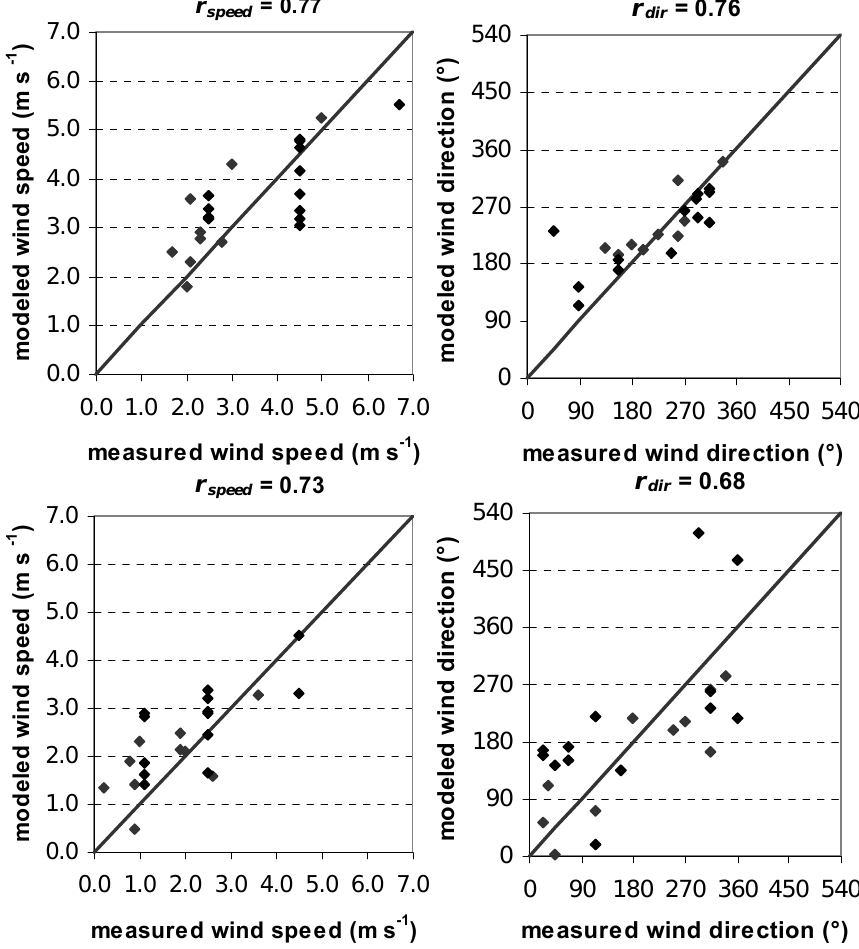
Fig. 3. The modeled versus measured hourly averaged surface wind speed (left) and wind direction (right) for 19 June 2000 at 14:00h (top) and at 21:00h (bottom). Black diamonds mark the comparison between the model and the data obtained from both automatic meteorological and climatological stations (signed and unsigned dots in Fig. 1). The corresponding correlation coefficient is also given at each panel. In Figure 3: The modeled versus measured hourly averaged surface wind speed (left) and wind Figure 3: The modeled versus measured hourly averaged surface wind speed (left) and wind order to show exact discrepancies between the measured and modeled directions, wind directions spanning a range of 0–90 ◦ are sometimes enlarged by 360 ◦ direction (right) for 19 June 2000 at 1400 h (top) and at 2100 h (bottom). Black diamonds direction (right) for 19 June 2000 at 1400 h (top) and at 2100 h (bottom). Black diamonds Figure 3: The modeled versus measured hourly averaged surface wind speed (left) and wind Figure 3: The modeled versus measured hourly averaged surface wind speed (left) and wind mark the comparison between the model and the data obtained from both automatic direction (right) for 19 June 2000 at 1400 h (top) and at 2100 h (bottom). Black diamonds meteorological and climatological stations (signed and unsigned dots in Fig. 1). The direction (right) for 19 June 2000 at 1400 h (top) and at 2100 h (bottom). Black diamonds mark the comparison between the model and the data obtained from both automatic corresponding correlation coefficient is also given at each panel. In order to show exact mark the comparison between the model and the data obtained from both automatic meteorological and climatological stations (signed and unsigned dots in Fig. 1). The discrepancies between the measured and modeled directions, wind directions spanning a meteorological and climatological stations (signed and unsigned dots in Fig. 1). The corresponding correlation coefficient is also given at each panel. In order to show exact range of 0-90º are sometimes enlarged by 360º. corresponding correlation coefficient is also given at each panel. In order to show exact discrepancies between the measured and modeled directions, wind directions spanning a discrepancies between the measured and modeled directions, wind directions spanning a range of 0-90º are sometimes enlarged by 360º. range of 0-90º are sometimes enlarged by 360º.